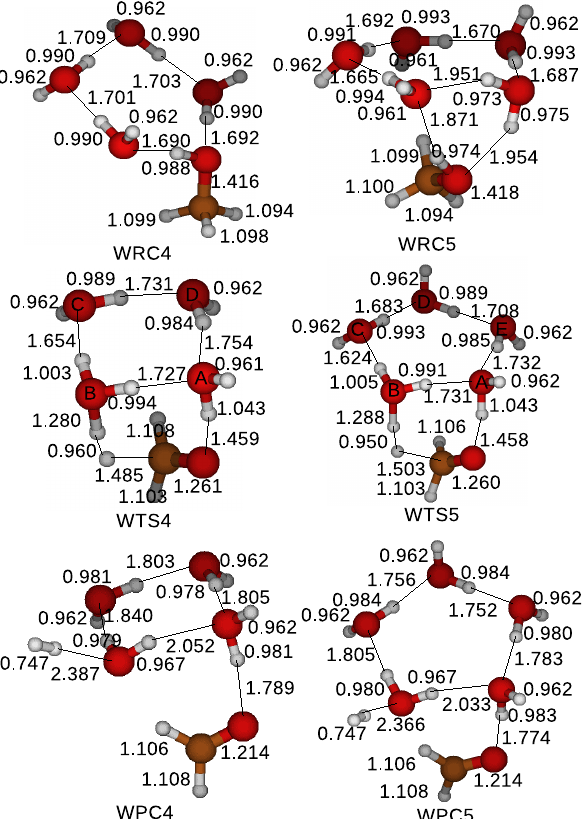
Figure 8. Optimized structures of a reactant compound, a transition state, and a product compound when a cluster of H O molecules catalyzes the oxidation of a CH OH. The Gaussian 4 method is 2 3 applied to locate and optimize the reactant compounds, transition states, and the product compounds. We consider clusters of 4 and 5 H O molecules in the simulations. Labels (A, B, C, D, E) are affixed to 2 oxygen atoms of H O molecules in transition states to distinguish. WRC n , WTS n , and WPC n stand 2 for a Reactant Compound, a Transition State, and a Product Compound for the oxidation of a CH OH 3 catalyzed by a cluster with n H O 2